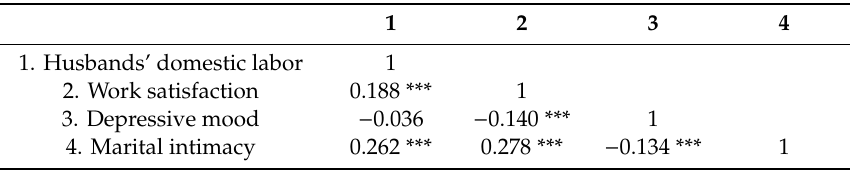
Table 3. Correlation among latent variables.